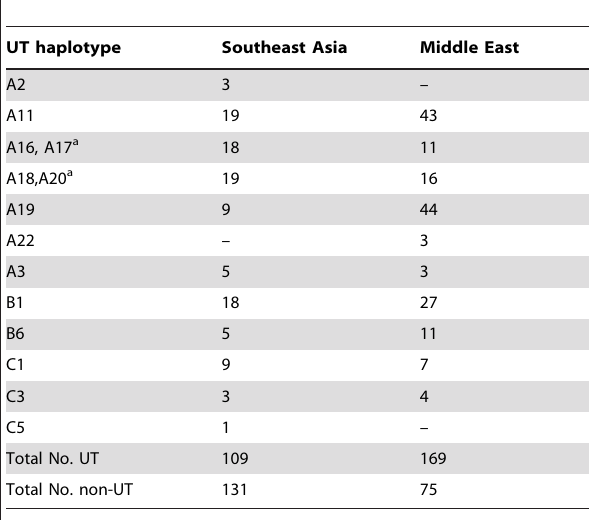
Table 1. Distribution of mtDNA haplotypes (402-bp from hypervariable region I) corresponding to ‘‘universally occurring’’ types (UT; [14]) in 431 village dogs from Southeast Asia and the Middle East.